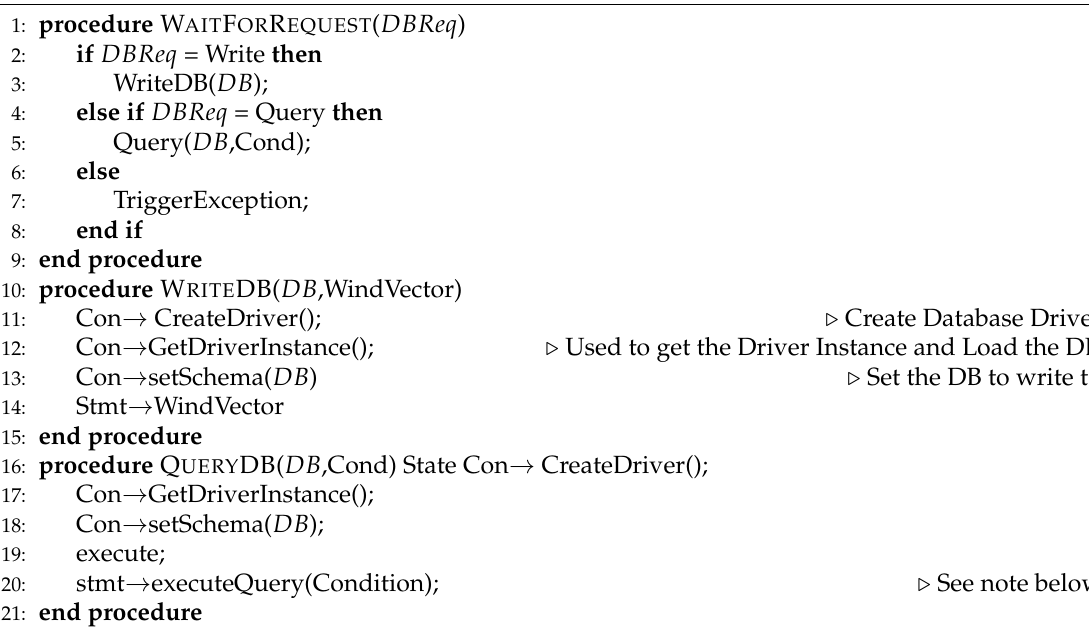
Algorithm 6 Database Access, Query and Writing